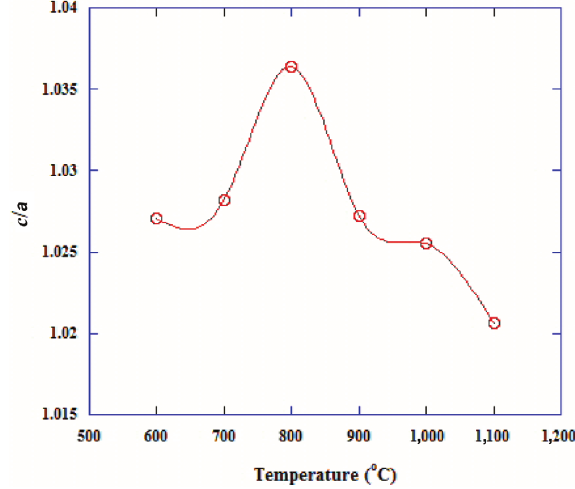
Figure 2: XRD patterns of Ba 0.85 Sm 0.1 TiO 3 from barium-smarium- titanium tartrate precursor thermally treated at different annealing temperatures for 2 h.